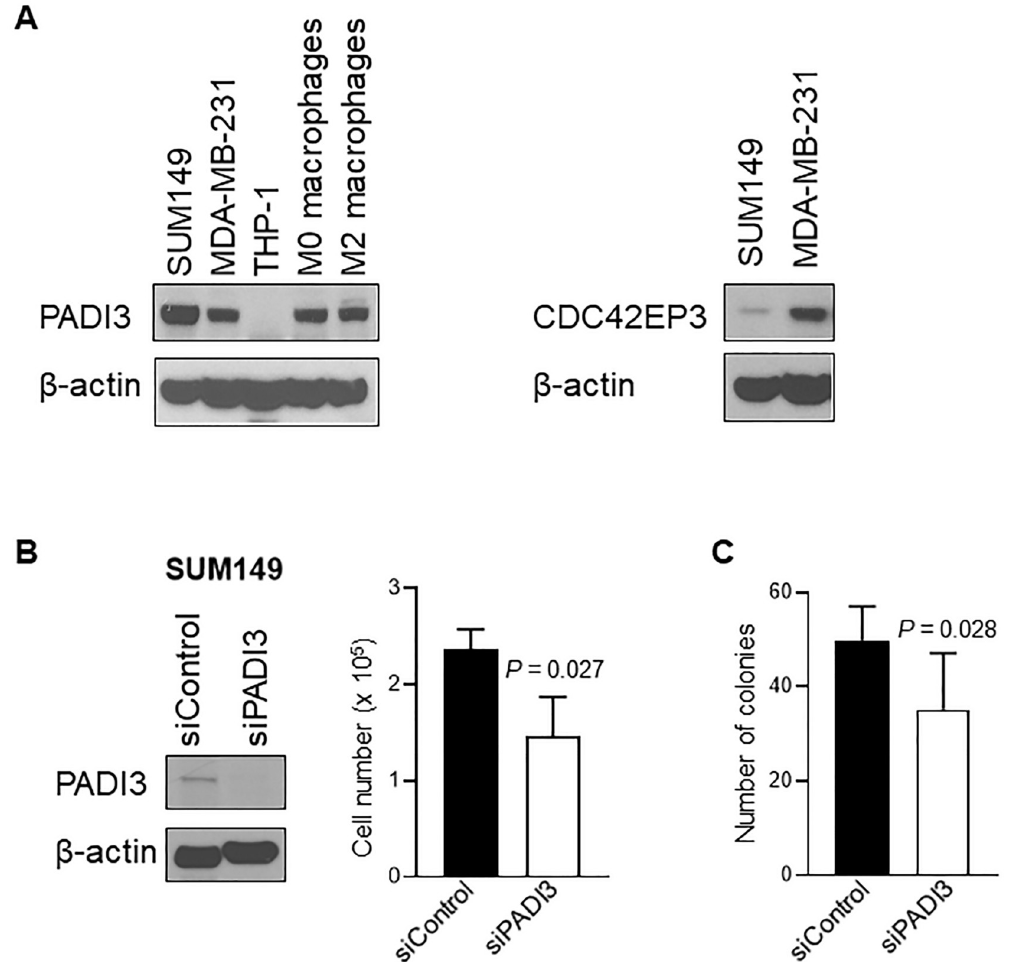
Fig 3. Analysis of PADI3 and CDC42EP3. (A) The expression of PADI3 and CDC42EP3 in breast cancer cell lines and macrophages . Expressions of PADI3 in SUM149 (TN-IBC), MDA-MB-231 (TN-non-IBC) cells, THP-1 (monocytes), M0 macrophages (THP-1-derived immature macrophages) and M2 macrophages (THP-1–derived M2 macrophages) were analyzed with Western blotting. Expressions of CDC42EP3 in SUM149 and MDA-MB231 were analyzed with Western blotting. (B) PADI3 knockdown suppresses cell growth in SUM149 . Left panel: The expression of PADI3 in SUM149 cells was depleted with siRNA and the expression of PADI3 in siControl and siPADI3 was analyzed with western blot. Right panel: Proliferation of SUM149 cells transfected with siControl and siPADI3 was measured by Trypan blue exclusion assay. Bars, SD. (C) PADI3 knockdown suppresses anchorage-independent growth of SUM149 cells . Bars, SD.